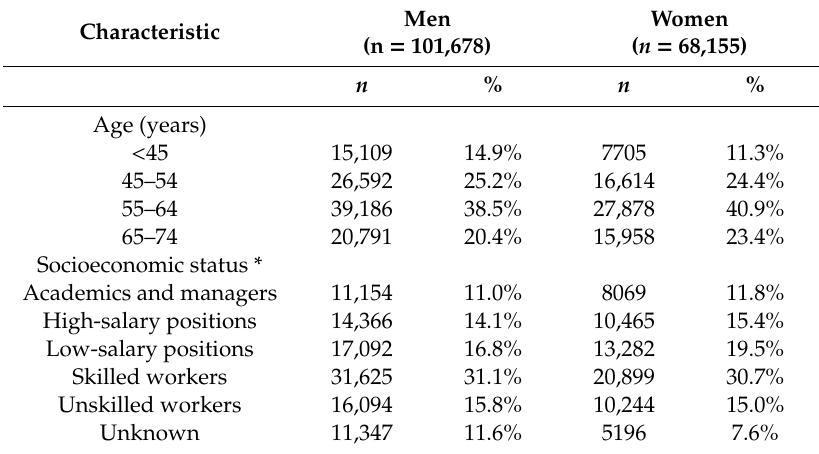
Table 1. Demographic Characteristics at the Index Date by